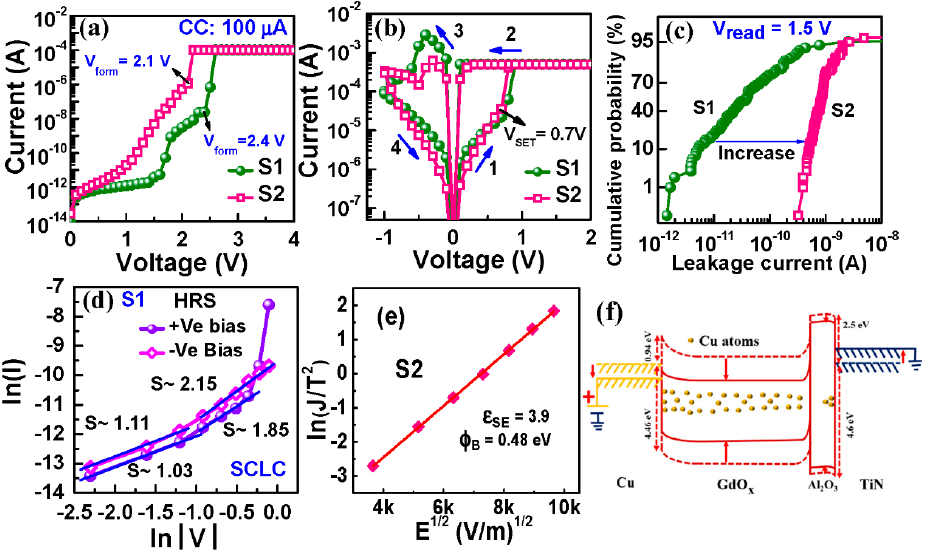
Figure 4. Current-voltage and current transport characteristics of the S1 and S2 devices. ( a ) Formation, ( b ) typical bipolar resistive switching, ( c ) cumulative probability of leakage current. ( d ) Space-charge-limited current (SCLC) conduction of the S1 devices, ( e ) Schottky conduction of the S2 memristor. ( f ) Schottky conduction at a high resistance state (HRS) is represented by the energy band diagram. Cu migration is also shown.